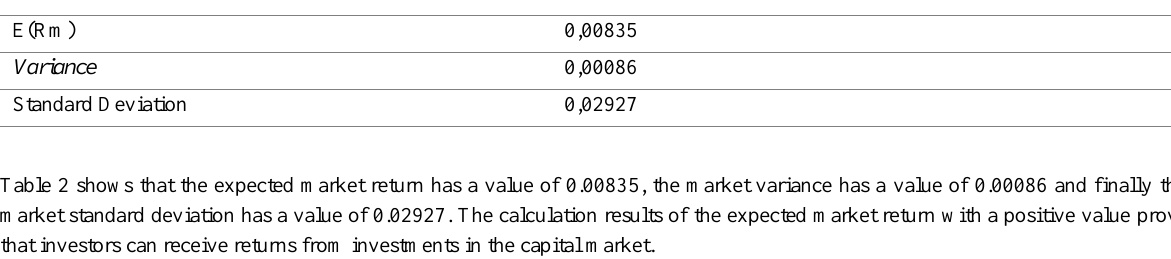
Table 2: Expected Return, Variance, and standard deviation in